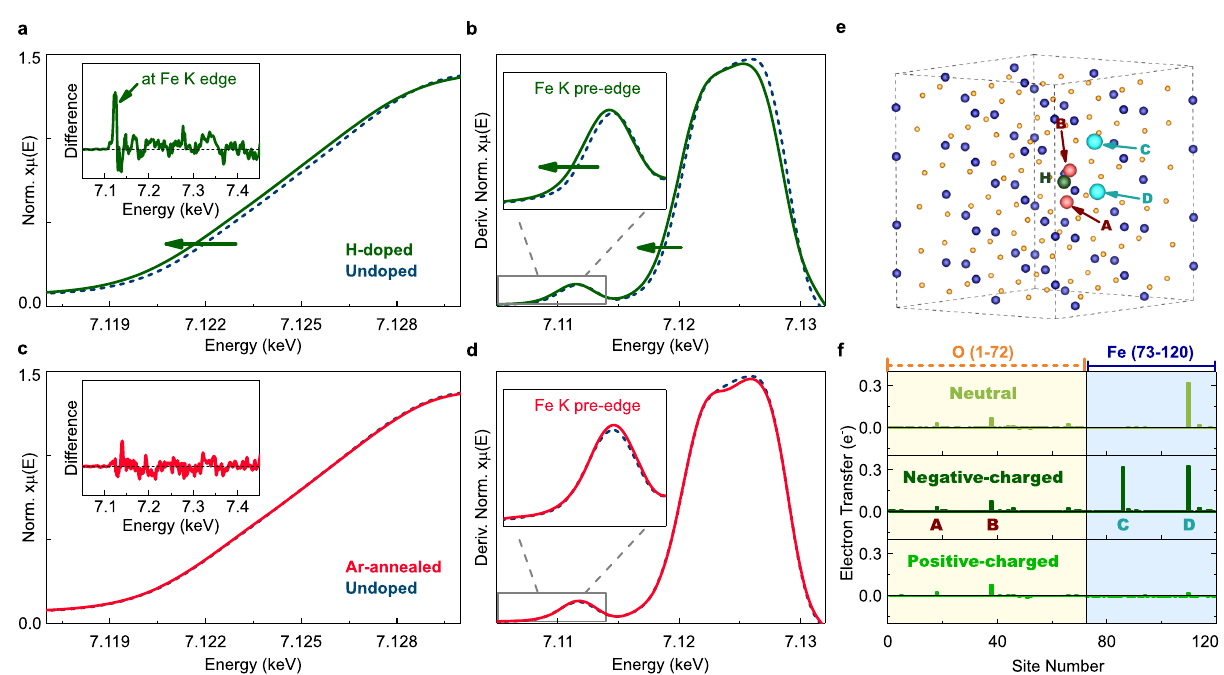
Fig. 3 Localised electron injection at Fe cations driven by H-doping. a , b Normalized Fe K edge XANES spectra ( a ) and their derivatives ( b ) of the H-doped (green solid line) and undoped (blue dashed line) α -Fe 2 O 3 fi lms, respectively. The main-edge of H-doped samples is red-shifted relative to the undoped counterparts (see Supplementary-S9 for complete Fe K edge spectrum). Inset in ( a ) shows difference spectrum (H-doped – Undoped) with a sharp positive peak at the near-edge and negligible changes in the extended-edge regions. Inset in ( b ) shows a red-shift of the pre-edge shoulder after H-doping. c , d Normalized XANES spectra ( c ) and their derivatives ( d ) of the Ar-annealed (red solid line) control and undoped α -Fe 2 O 3 fi lms, respectively. Spectrum of the Ar-annealed samples shows no energy shift relative to the undoped counterpart. Inset in ( c ) shows the difference spectrum (Ar- annealed – Undoped) with negligible changes in all regions. Inset in ( d ) reveals the absence of a shift in the pre-edge shoulder. e 2 × 2 × 1 hexagonal super- cell of α -Fe 2 O 3 with Fe (blue) and O (orange) atoms (120 in total). Speci fi c Fe or O-sites demarcated as C/D (cyan) or A/B (red), respectively, that receive signi fi cant fraction of the Bader-charge from the interstitial H-dopant (green). f Effective Bader-charge transferred to the 120 atoms obtained from DFT calculations after addition of H-dopant in the super-cell. Here positive and negative peaks correspond to electron injection to and withdrawal from that site, respectively. Neutral and charge-doped regimes of α -Fe 2 O 3 are obtained by modifying the quantum of the excess electronic charge added to the super-cell (see ‘ Methods ’ and Supplementary-S15). The O and Fe sites are labelled 1 – 72 and 73 – 120,